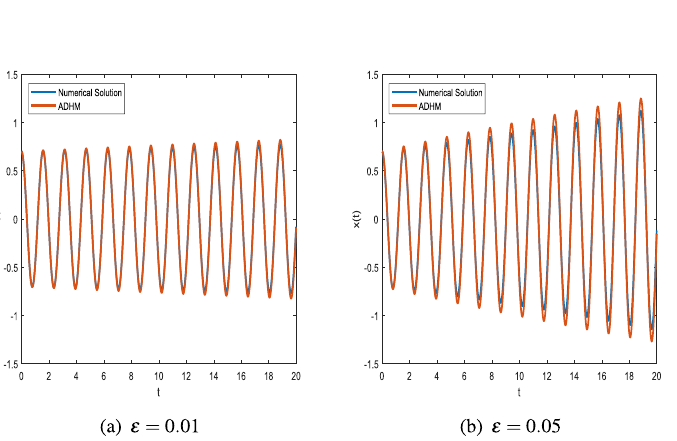
Figure 5. Comparison of ADHM results and numerical solution for parametric values x 0 = 0.7 and ω = 4